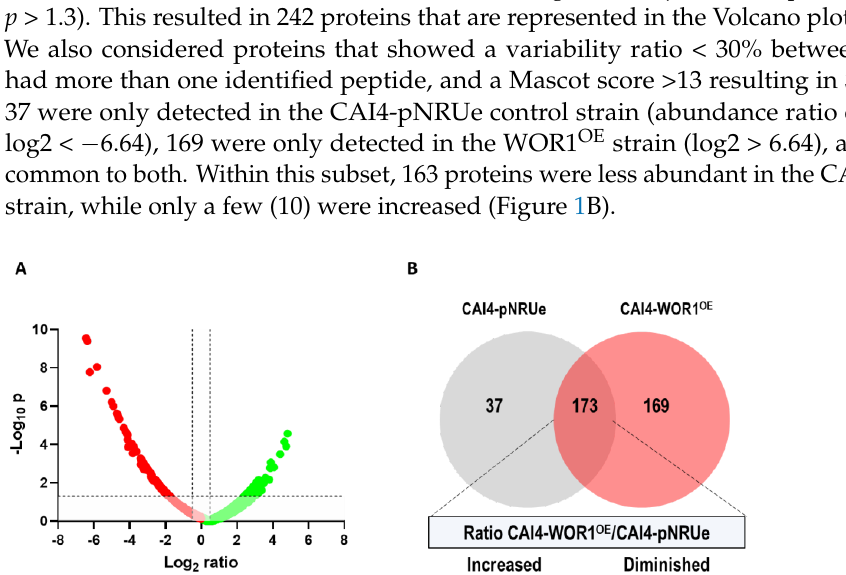
lated by white-opaque switch, were less abundant in cells overproducing Wor1, thus, val- idating our data.